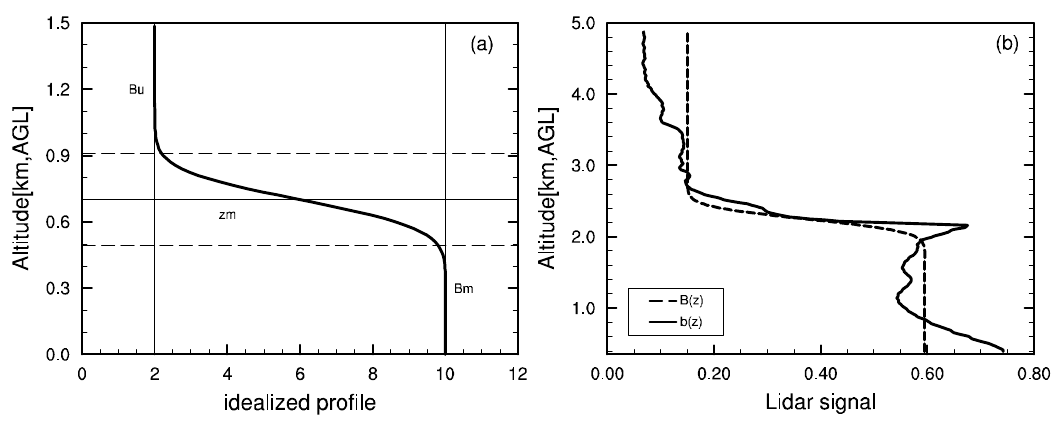
Figure 4. ( a ) An idealized ABL backscatter profile, ( b ) the curve fitting procedure for a case at 12:00 UTC on 10 September 2010 over SACOL (the same case in Figure 3; adapted from the Figure 2 in Dang et al. [56]).